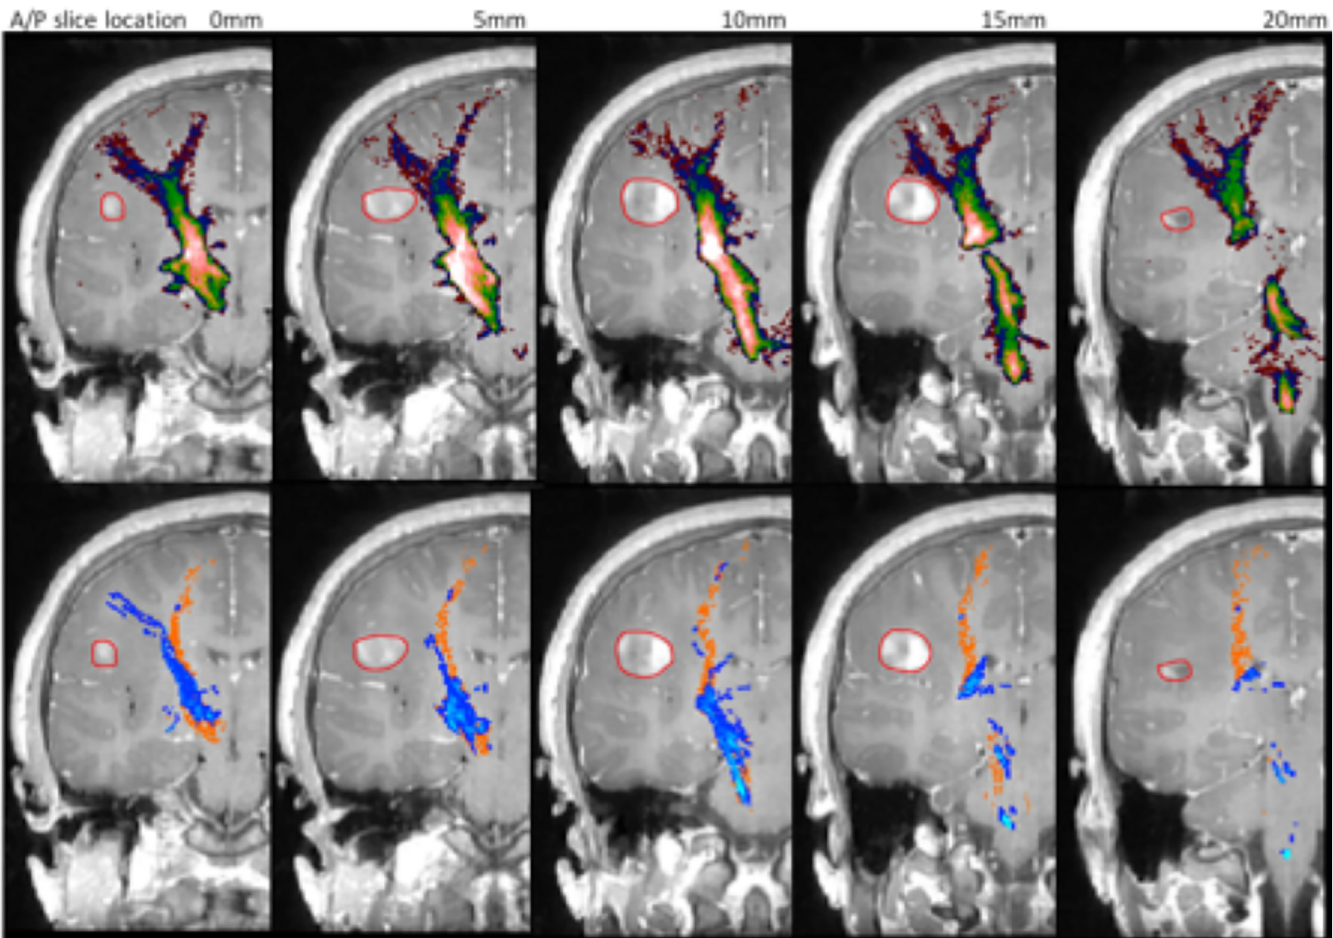
Fig 9. Tractography of the CST for patient 1. Top row: Prob 0.005 (red), Prob 0.01 (dark blue), Prob 0.025 (green), Prob 0.05 (yellow), Prob 0.075 (pink). Bottom row: CSD-stream (blue), STEALTH (orange). Lesion is outlined in red.